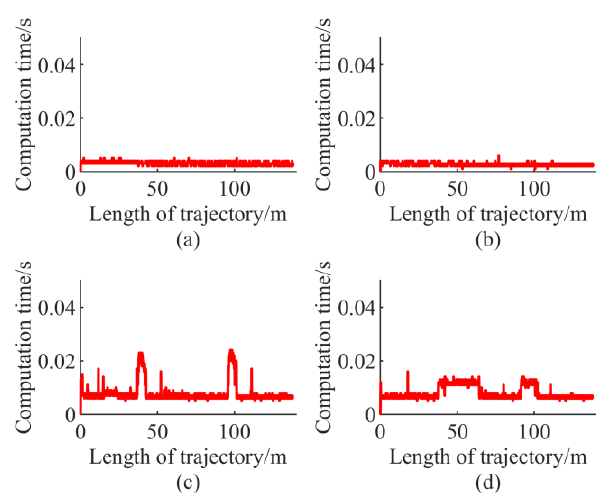
Figure 5. The heading error when velocity is 2 m/s. ( a ) LMPC. ( b ) LEMPC. ( c ) NMPC. ( d ) NEMPC.